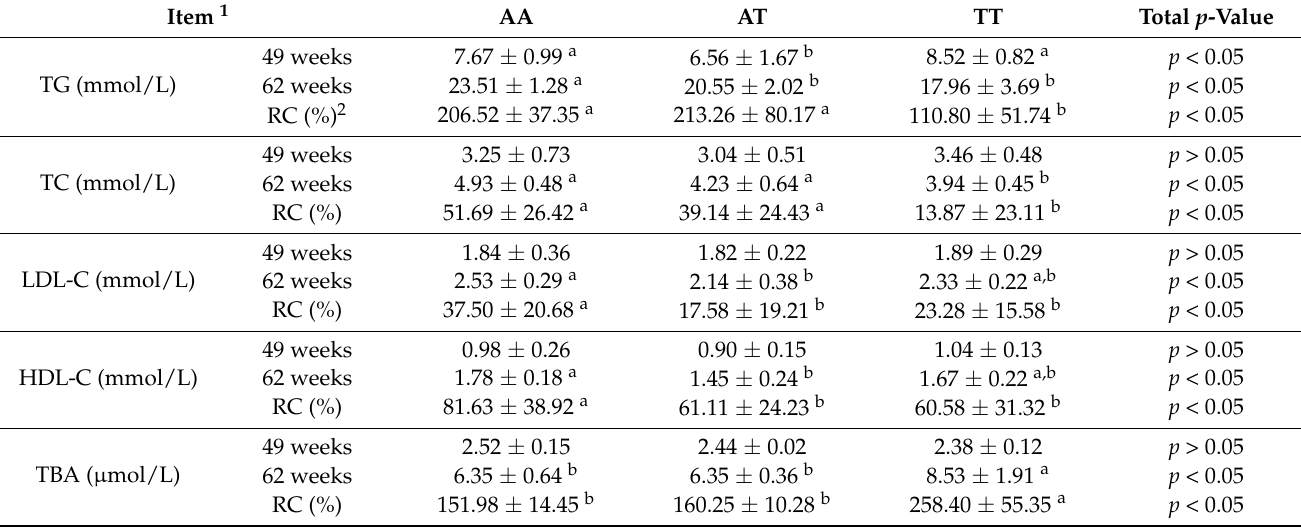
Table 1. Serum physiological parameters of laying hens with different FMO3 genotypes at 49 and 62 weeks of